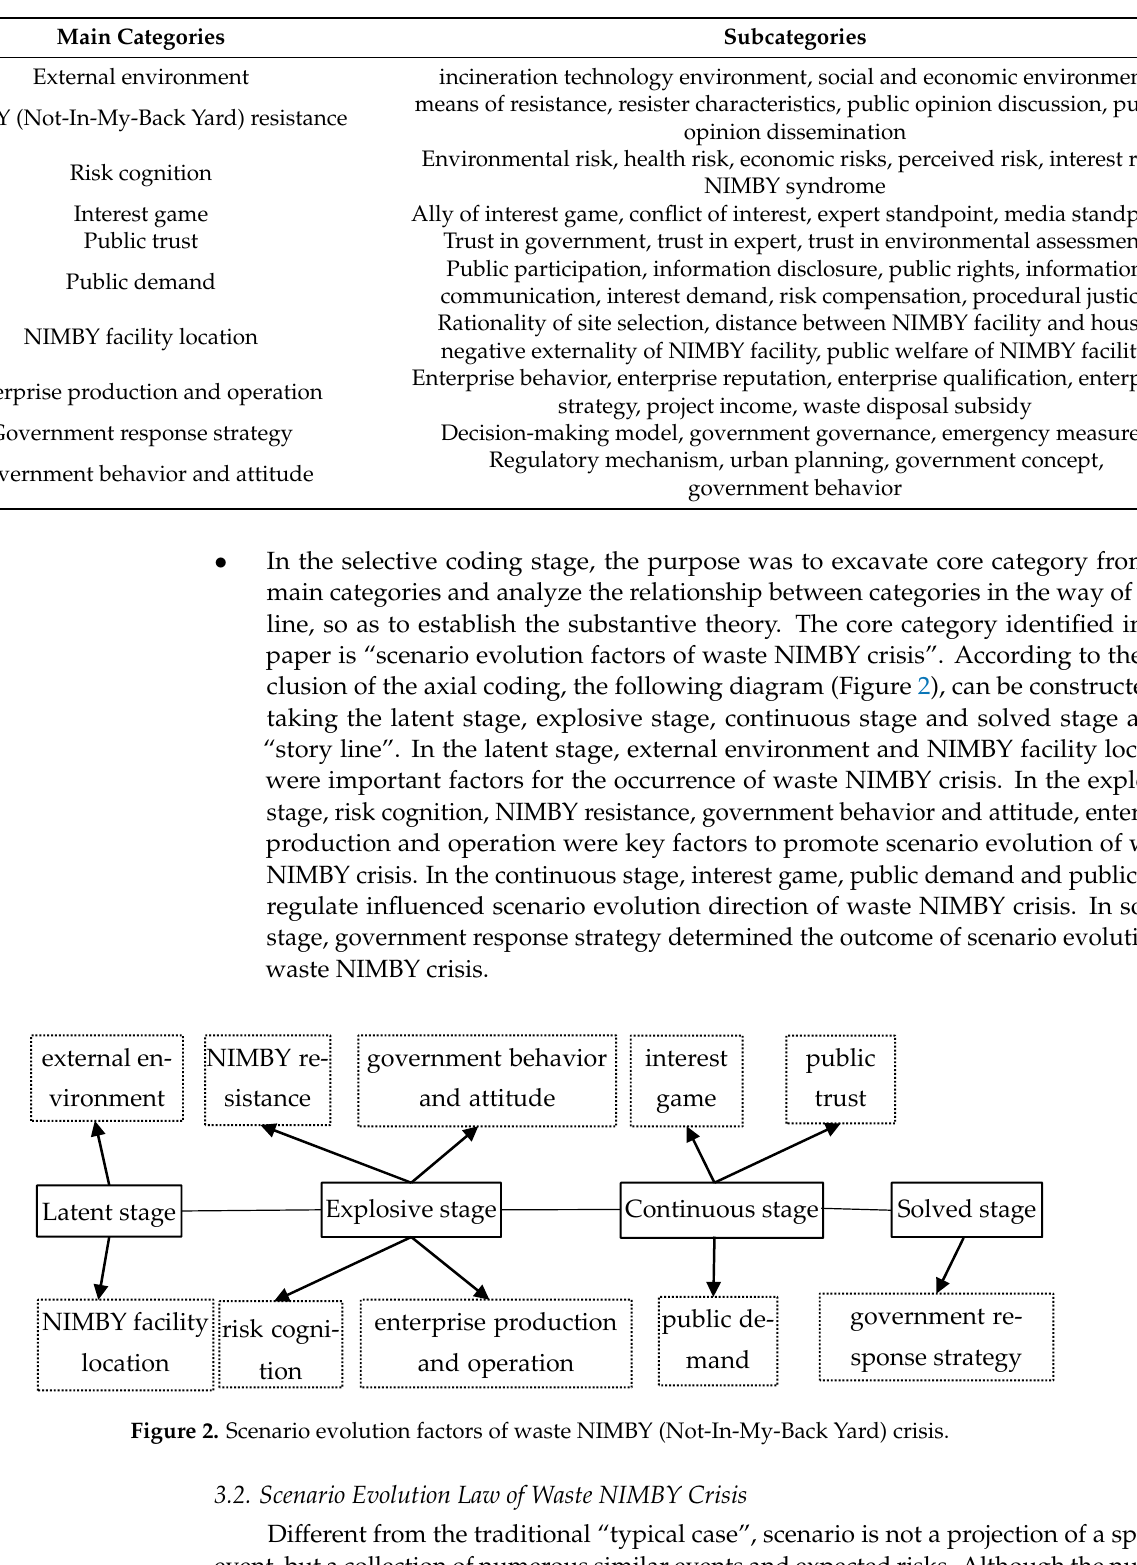
Table 2. Ten main categories based on axial coding.